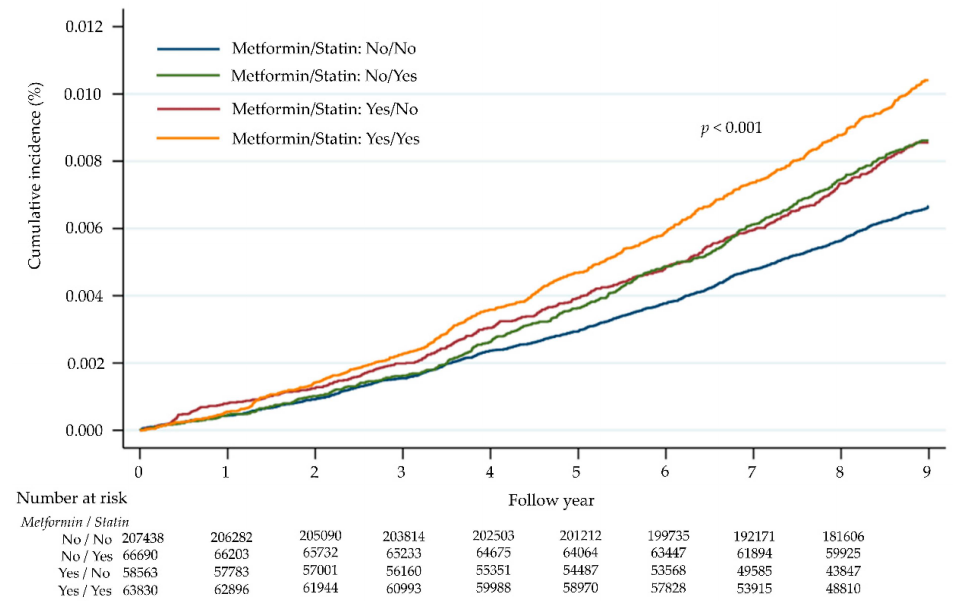
Figure 2. Cumulative incidence of female colorectal cancer based on different scenarios of metformin and statin use.